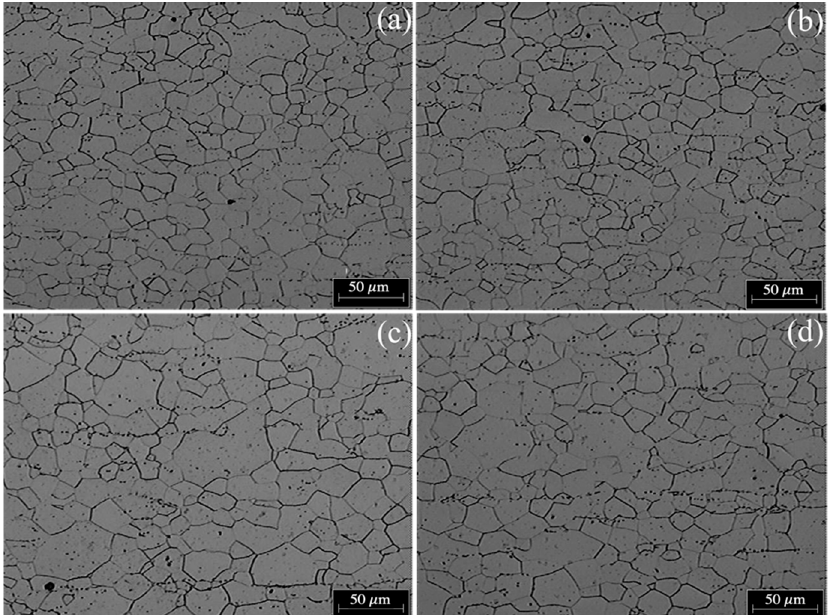
Figure 1. Microstructures of deformed semi-processed grain non-oriented electrical steel ( a ) 0%, ( b ) 5%, ( c ) 10% and ( d ) 20%.